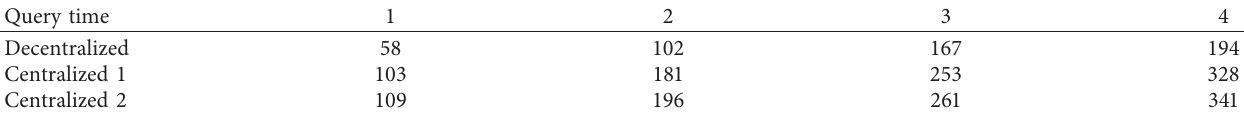
Table 4: Query rate comparison